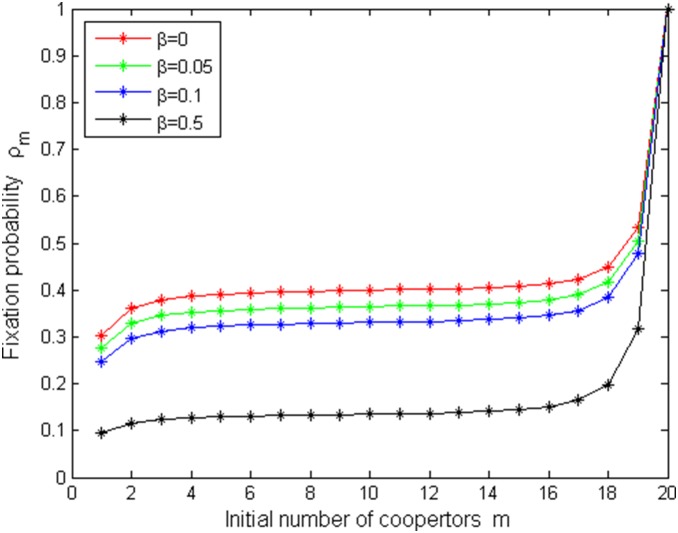
ρm vs N with µ = 0.95, b = 1.2 and different β values.